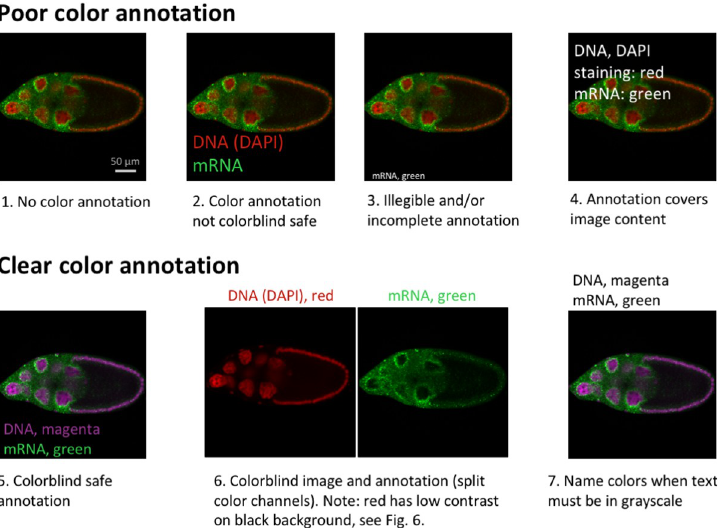
Fig 12. Explain color in images. Cells and their structures are almost all transparent. Every dye, stain, and fluorescent label therefore should be clearly explained to the audience. Labels should be colorblind safe. Large labels that stand out against the background are easy to read. Authors can make figures easier to interpret by placing the color label close to the structure; color labels should only be placed in the figure legend when this is not possible. Example images were created based on problems observed by reviewers. Microscope images show D . melanogaster egg chambers stained with the DNA dye DAPI (4 0 ,6-diamidino-2-phenylindole) and probe for a specific mRNA species [18]. All images have the same scale.